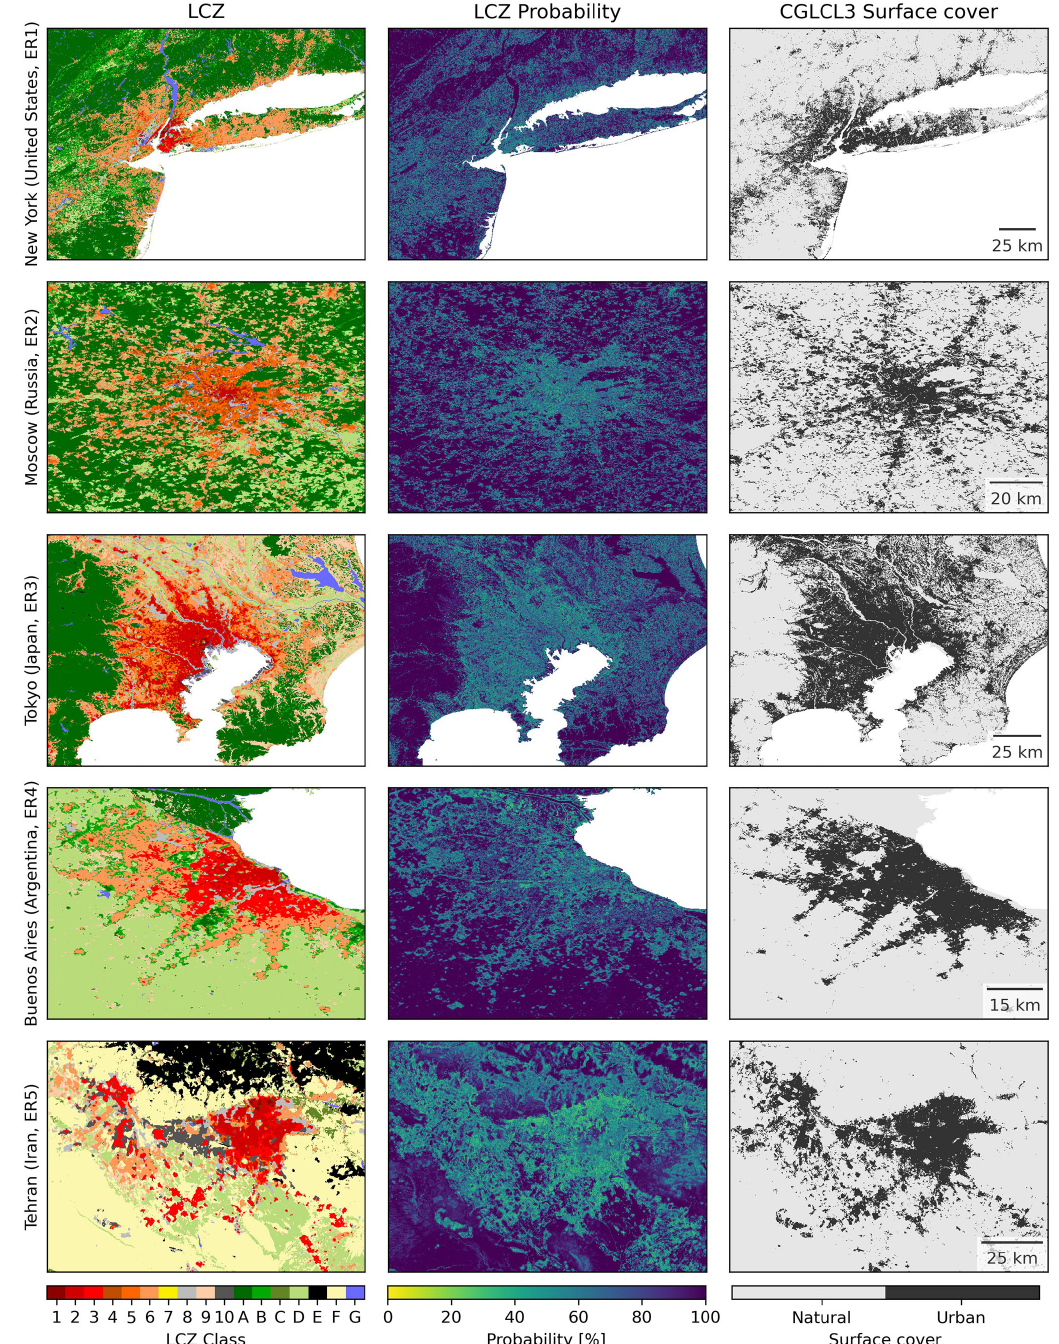
Figure 5. LCZ map, its classification probability, and the corresponding binary Copernicus urban land cover (CGLCL3) for the largest functional urban areas in urban ERs 1 to